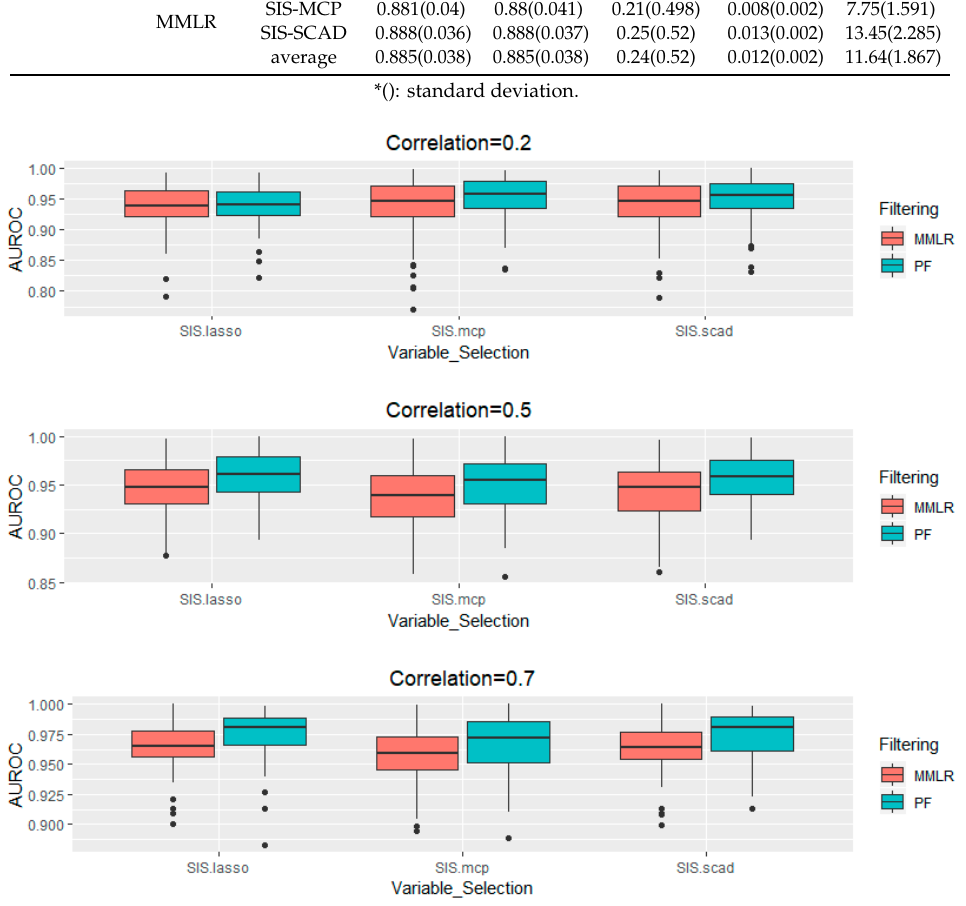
Figure 3. Comparison of area under the receiver operating characteristic (AUROC) with SIS-LASSO, SIS-MCP, and SIS-SCAD after filtering with both proposed filter ranking method and MMLR method under three correlation settings.